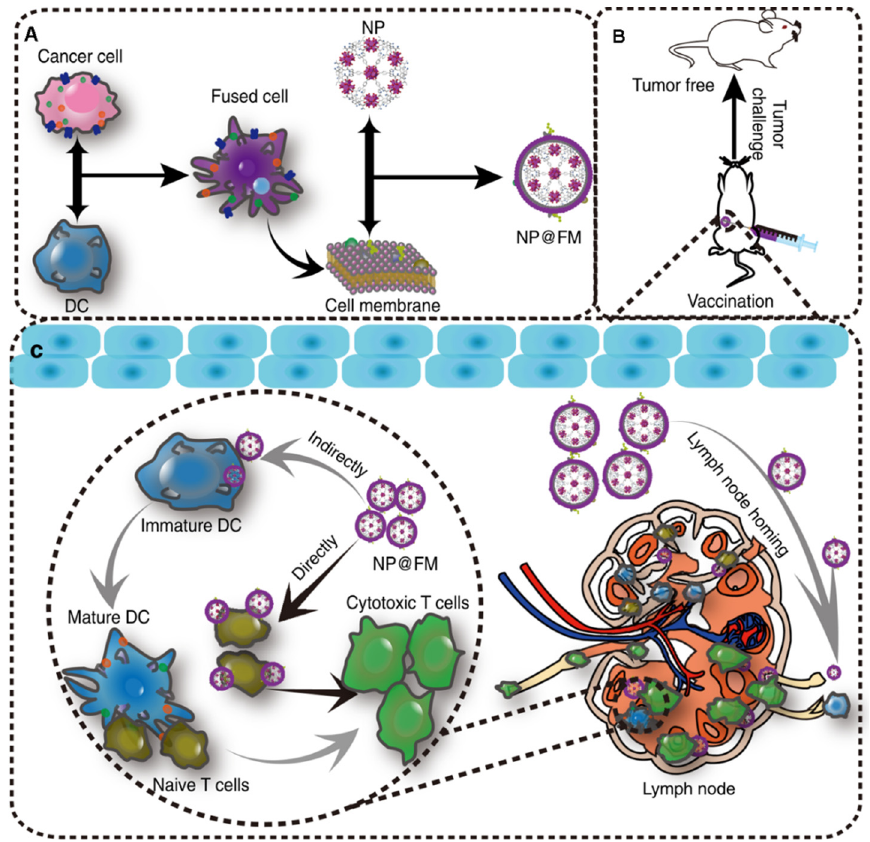
Figure 5. Fusion vesicles encapsulating MOFs for tumor prevention. ( A ) Preparation of fused vesicles encapsulating MOFs. ( B ) Fusion vesicle vaccination for tumor prophylaxis. ( C ) Mechanisms by which fusion vesicles induce immune response. Reprinted/adapted with permission from Ref. [62]. 2019, Springer Nature.